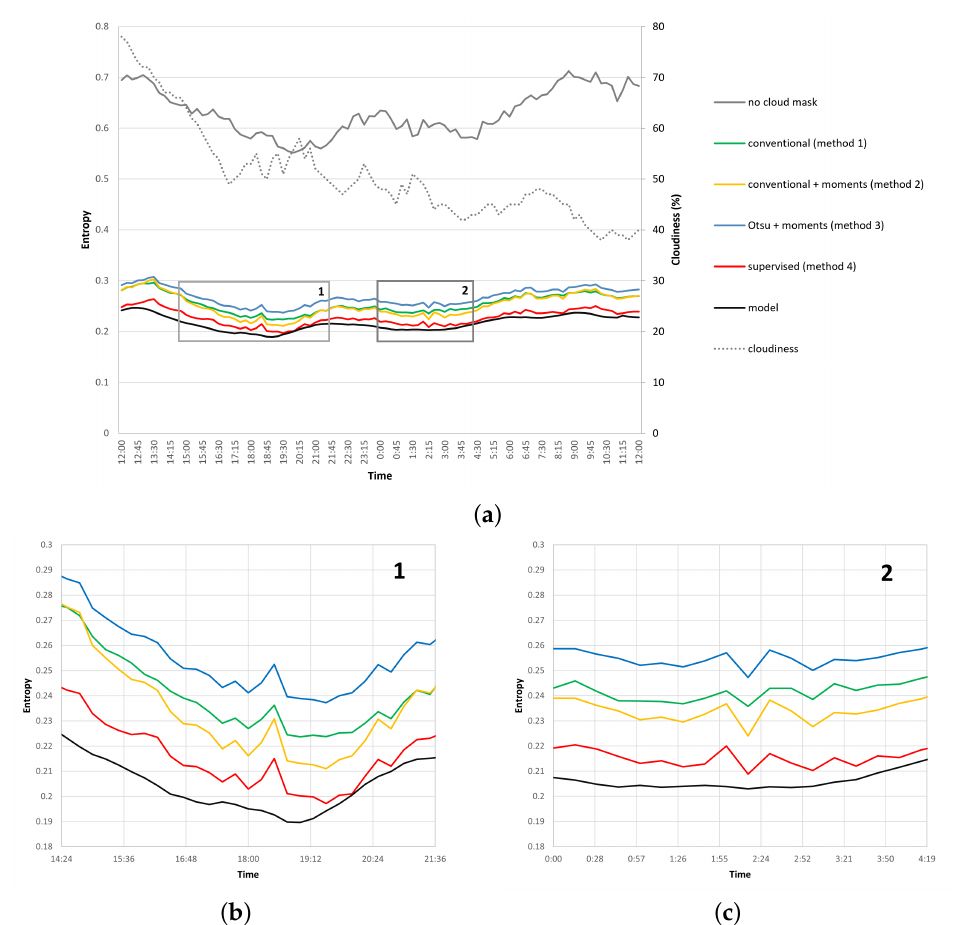
Figure 7. Results of entropy calculation for methods 1–4, black line according to the lower limit of the entropy calculated for the cloudless map ( a ); ( b , c ) selected periods in which the application of the moment method improves the